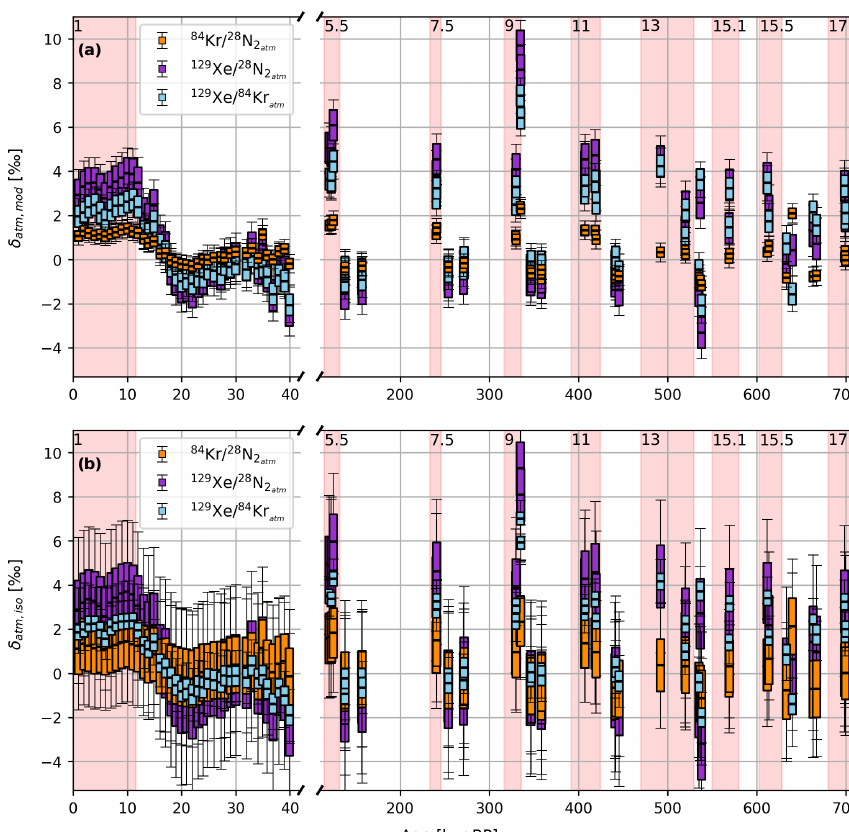
Figure 5. Comparison of the reconstructed atmospheric ratios of Kr / N 2 (orange), Xe / N 2 (purple), and Xe / Kr (blue) (a) as derived from the calibrated firn model of Michel (2016) (b) using measured isotopic ratios only. The reconstructed value is drawn as a black line in the middle of each box. The magnitude of the systematic uncertainty is indicated by the size of the colored boxes, and the statistical uncertainties are depicted as whiskers (1 σ each). The red shaded intervals and the MIS numbers on top indicate interglacials as identified by Masson-Delmotte et al.